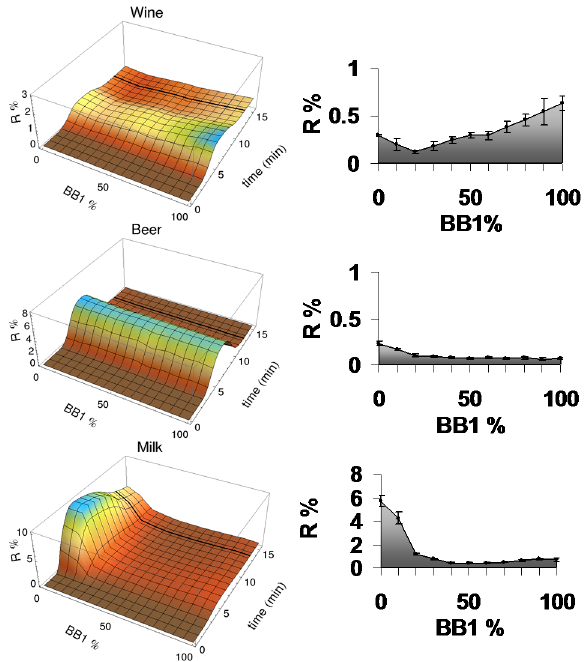
Figure 6. Differentiation of complex mixtures such as beverages by the eT. CEPs and CELs of red wine (Côtes du Rhône), beer (Leffe), and milk (UHT demi-écrémé). Reprinted from [29].